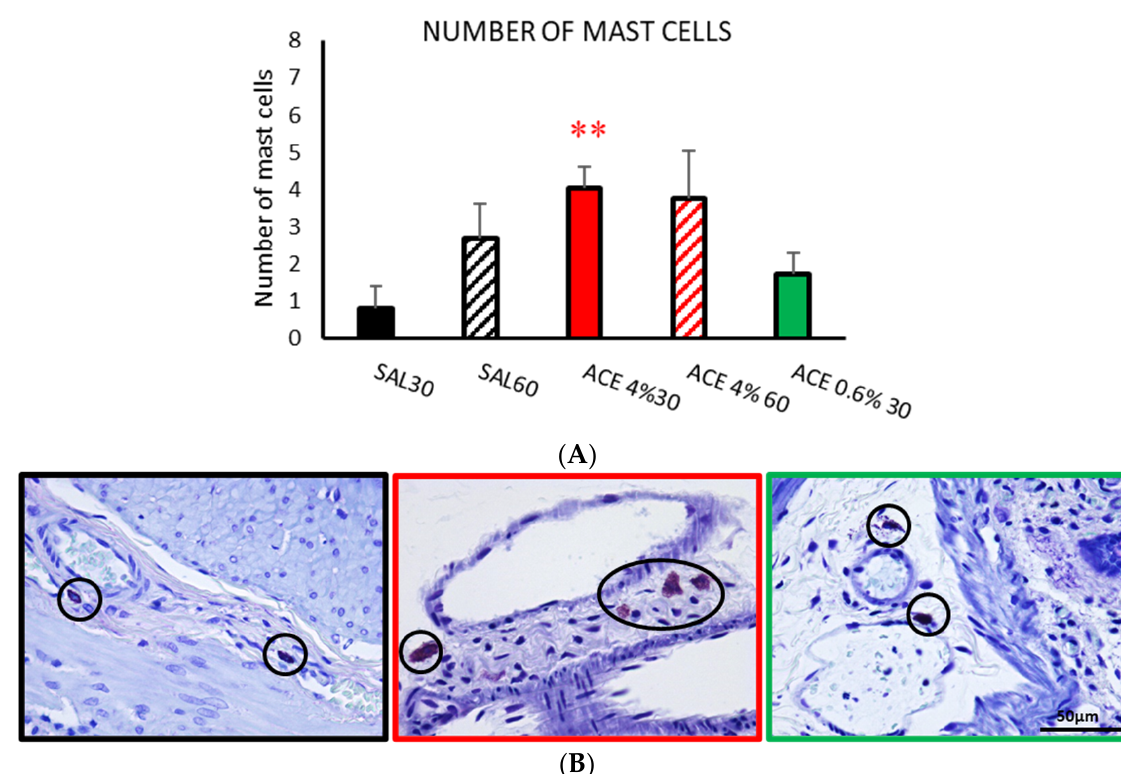
Figure 4. Effect of intracolonic administration of acetic acid on the number of mast cells, phase I (model selection). Colon sections of were stained with toluidine blue and studied under a Zeiss Axioskop 2 microscope. The number of mast cells ( A ) was counted in ten random fields per section across mucosa and submucosa. Experimental groups: SAL30, black bar; SAL60, black striped bar; ACE 4% 30, red bar; ACE 4% 60, red striped bar; ACE 0.6% 30, green bar. Data represent mean ± SEM. ** p < 0.01 vs. SAL30. One-way ANOVA followed by Bonferroni post hoc test ( n = 8–13). ( B ) Photomicrographs of mast cells stained with toluidine blue (circles) after intracolonic administration of SAL30 (black frame), ACE 4% 30 (red frame), or ACE 0.6% 30 (green frame). Scale bar = 50 μm.